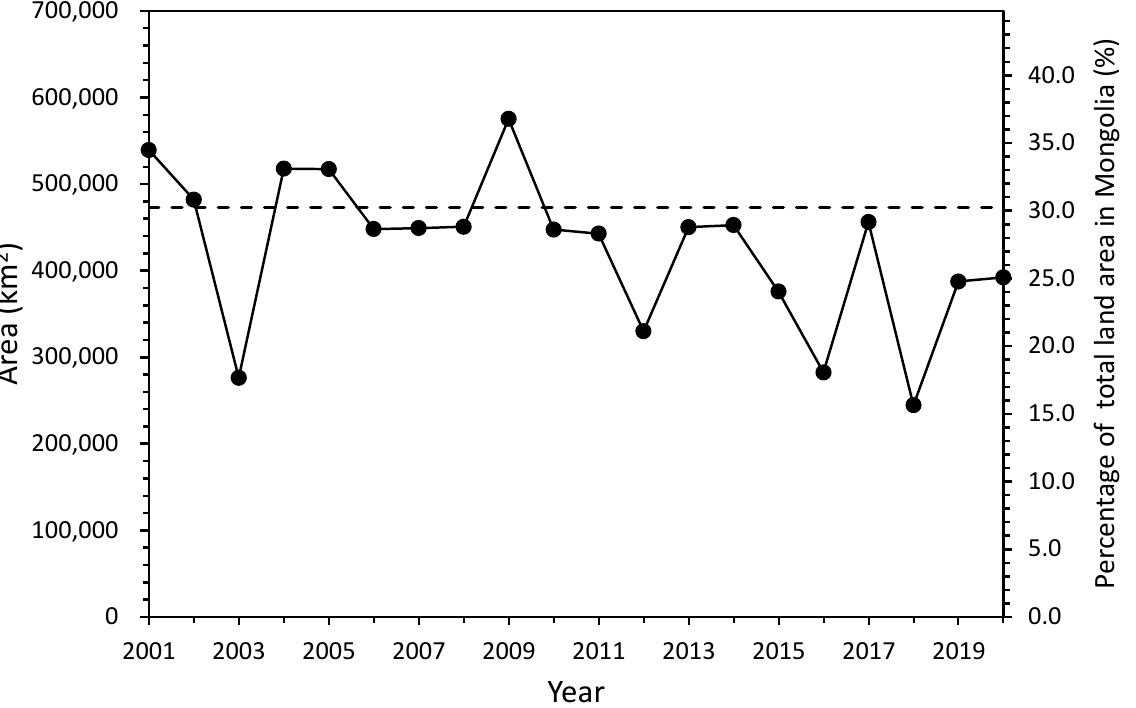
Figure 12. Annual changes of areas of degraded land and percentage of total land area in Mongolia. Dashed line represents the average extent of degraded land for 2001 to 2009.